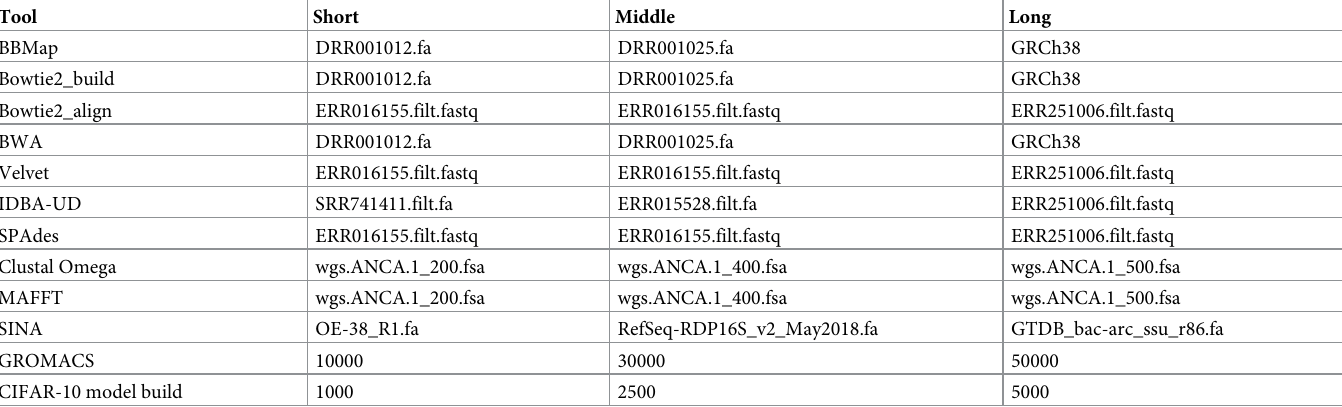
Table 4. Benchmark datasets assigned to the according tool and dataset parameters (Short, Middle, Long) of BOOTABLE .